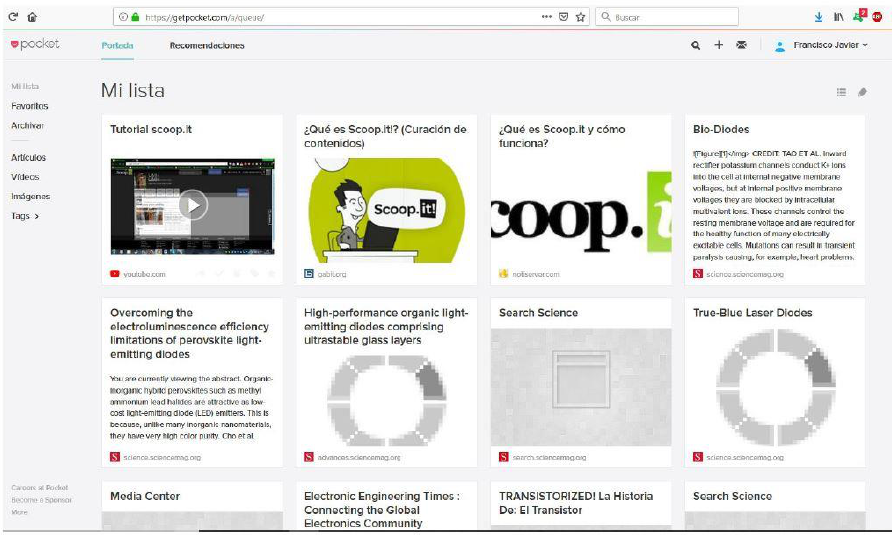
Figure 5. Example of a Pocket panel for the temporary storage of information.